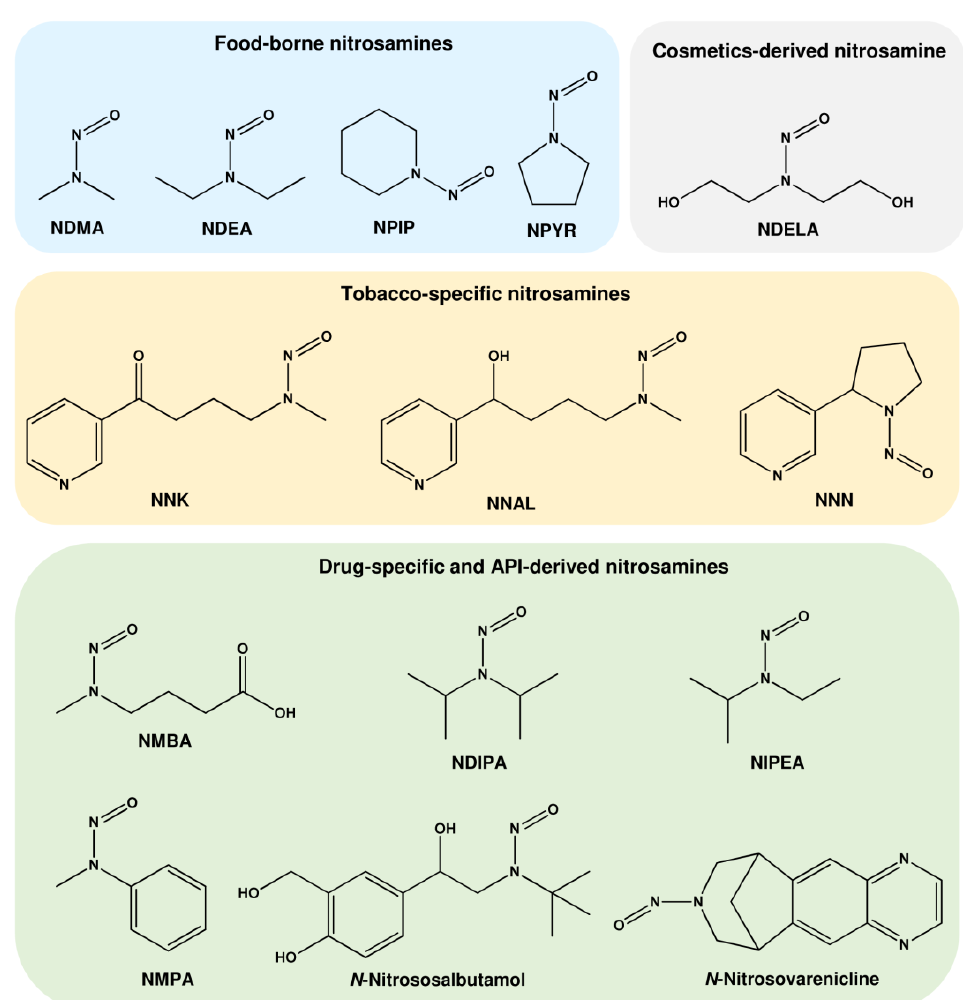
Figure 2. Chemical structure of important nitrosamines found in food, cosmetics, tobacco smoke, and drugs. NDMA: N -nitrosodimethylamine; NDEA: N -nitrosodiethylamine; NPIP: N -nitrosopiperidine; NPYR: N- nitrosopyrrolidine; NDELA: N -nitrosodiethanolamine; NNK: nicotine-derived nitrosamine ketone; NNAL: nicotine-derived nitrosamine alcohol; NNN: N ’-nitrosonornicotine; NMBA: N -nitroso- N -methyl-4-aminobutanoic acid; NDIPA: N -nitrosodiisopropylamine; NIPEA: N -nitrosoethylisopropylamine; NMPA: N - nitrosomethylphenylamine.